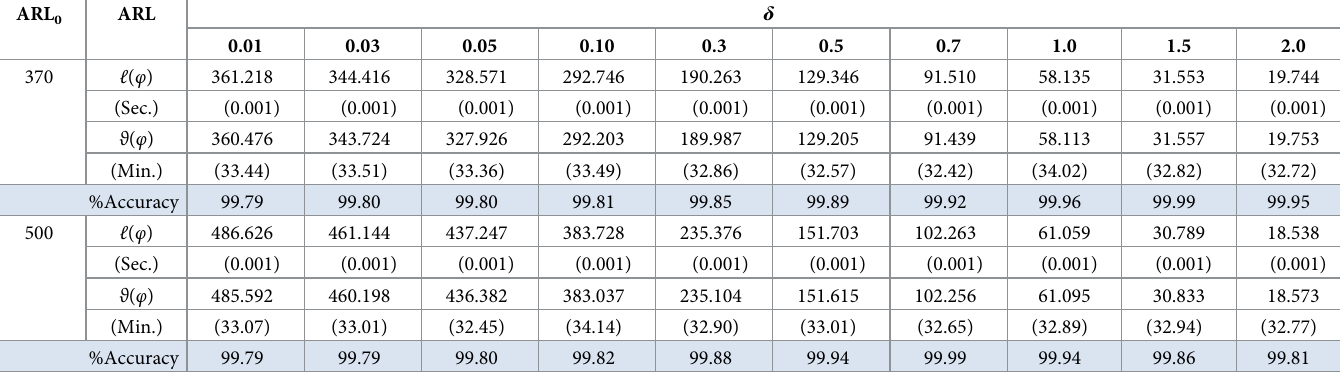
The results are expressed as percentage accuracy with the computational times in parentheses for the analytical IE (seconds) and numerical IE (minutes) methods.